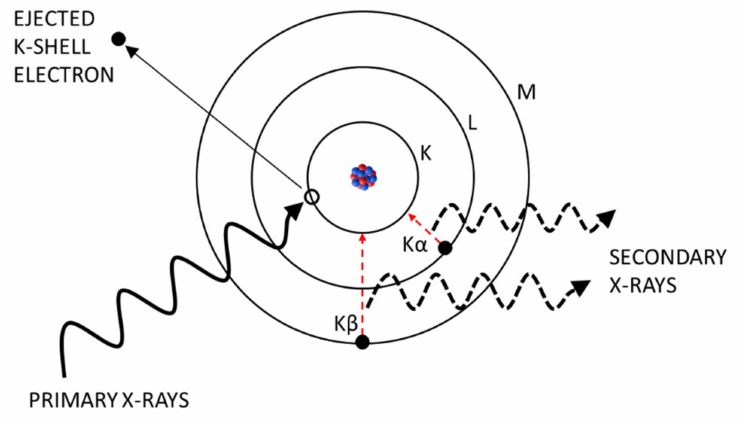
Figure 1. Physical mechanisms within an atom for